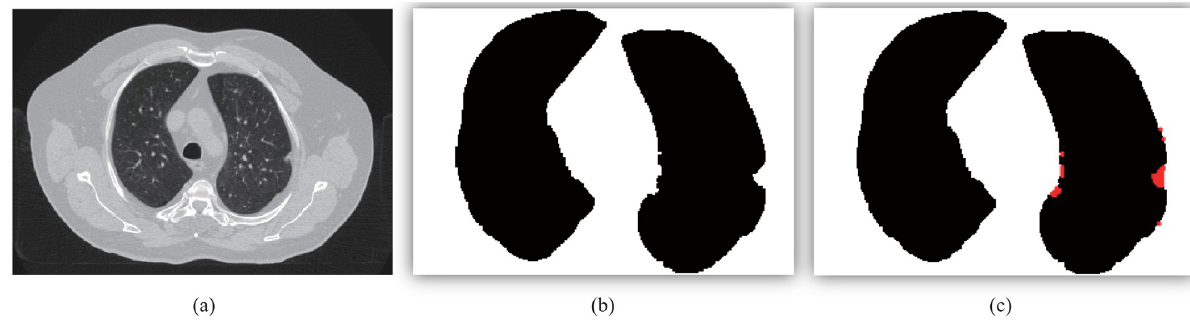
Fig 15. The correction effect comparison chart. (a) The original CT slice; (b) the extracted coarse lung binary region; (c) the corrected lung region.